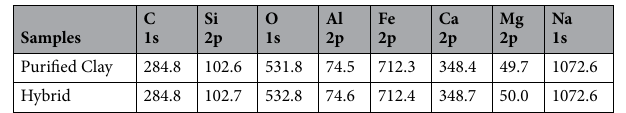
Table 8. Binding energies of starting clay before and after the adsorption process of EO.